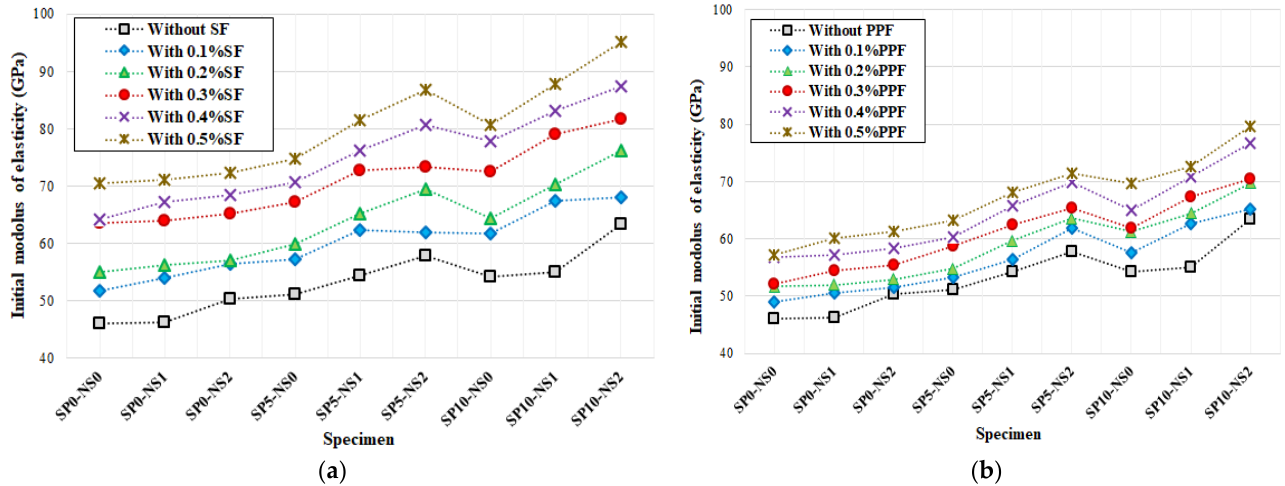
Figure 13. Compressive–tensile strength relationship of PPF reinforced HSC containing NS and SP.